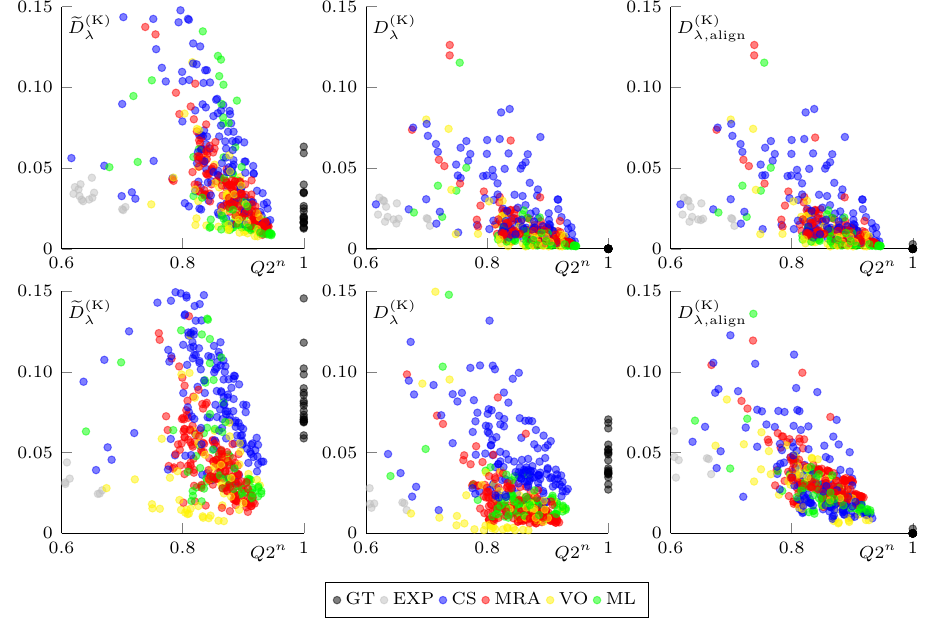
= 1 Figure 4. From left to right, (cid:101) D ( K ) , D ( K ) , and D ( K ) R- Q 2 n vs. Q 2 n on the WV2 RR dataset. λ λ λ ,align − Both the “aligned” ( top ) and “misaligned” ( bottom ) dataset cases are shown. Each marker is associated with a single pansharpening result on a 512 512 tile. Black markers correspond to × the ground truth. Light gray ones (EXP) correspond to a simple interpolation. The remaining clusters correspond to the different algorithms grouped by categories.